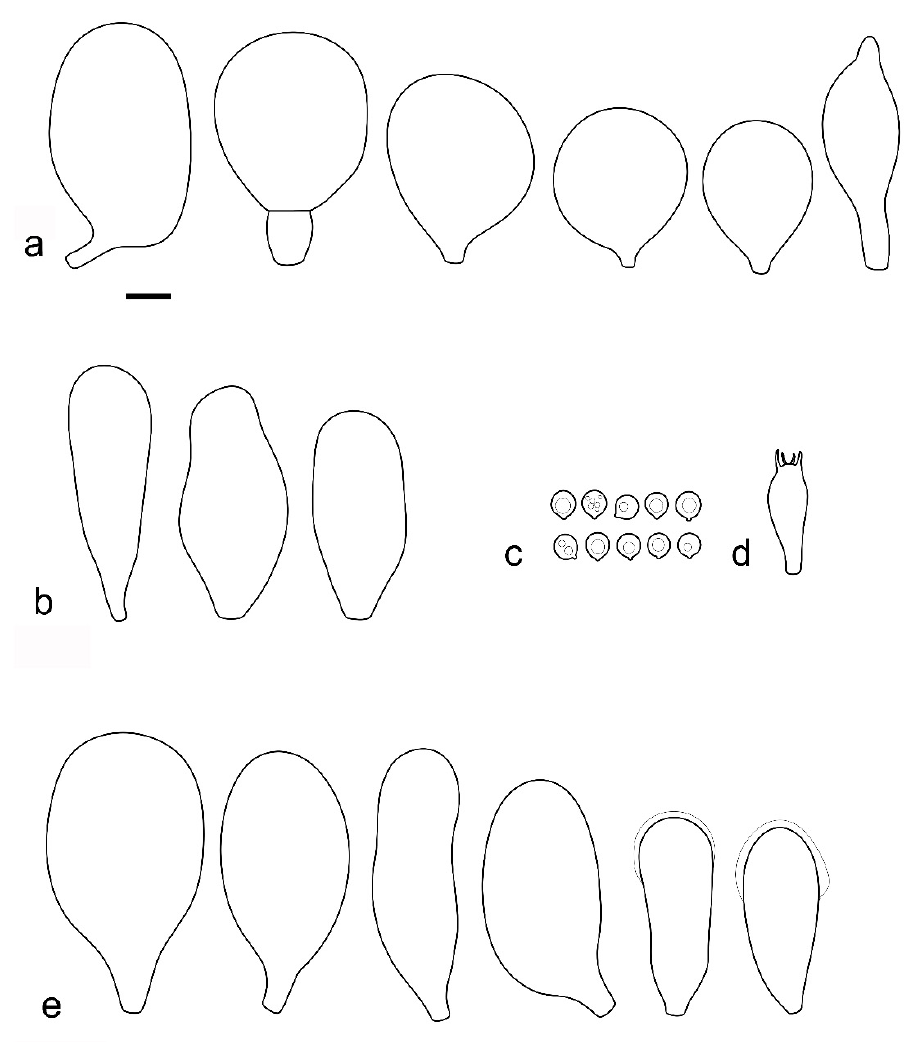
Figure 17. Pluteus parvicarpus holotype LE 313357: ( a ). pileipellis elements, ( b ). pleurocystidia, ( c ). basidiospores, ( d ). basidium, ( e ). cheilocystidia. Scale bar 10 µm.